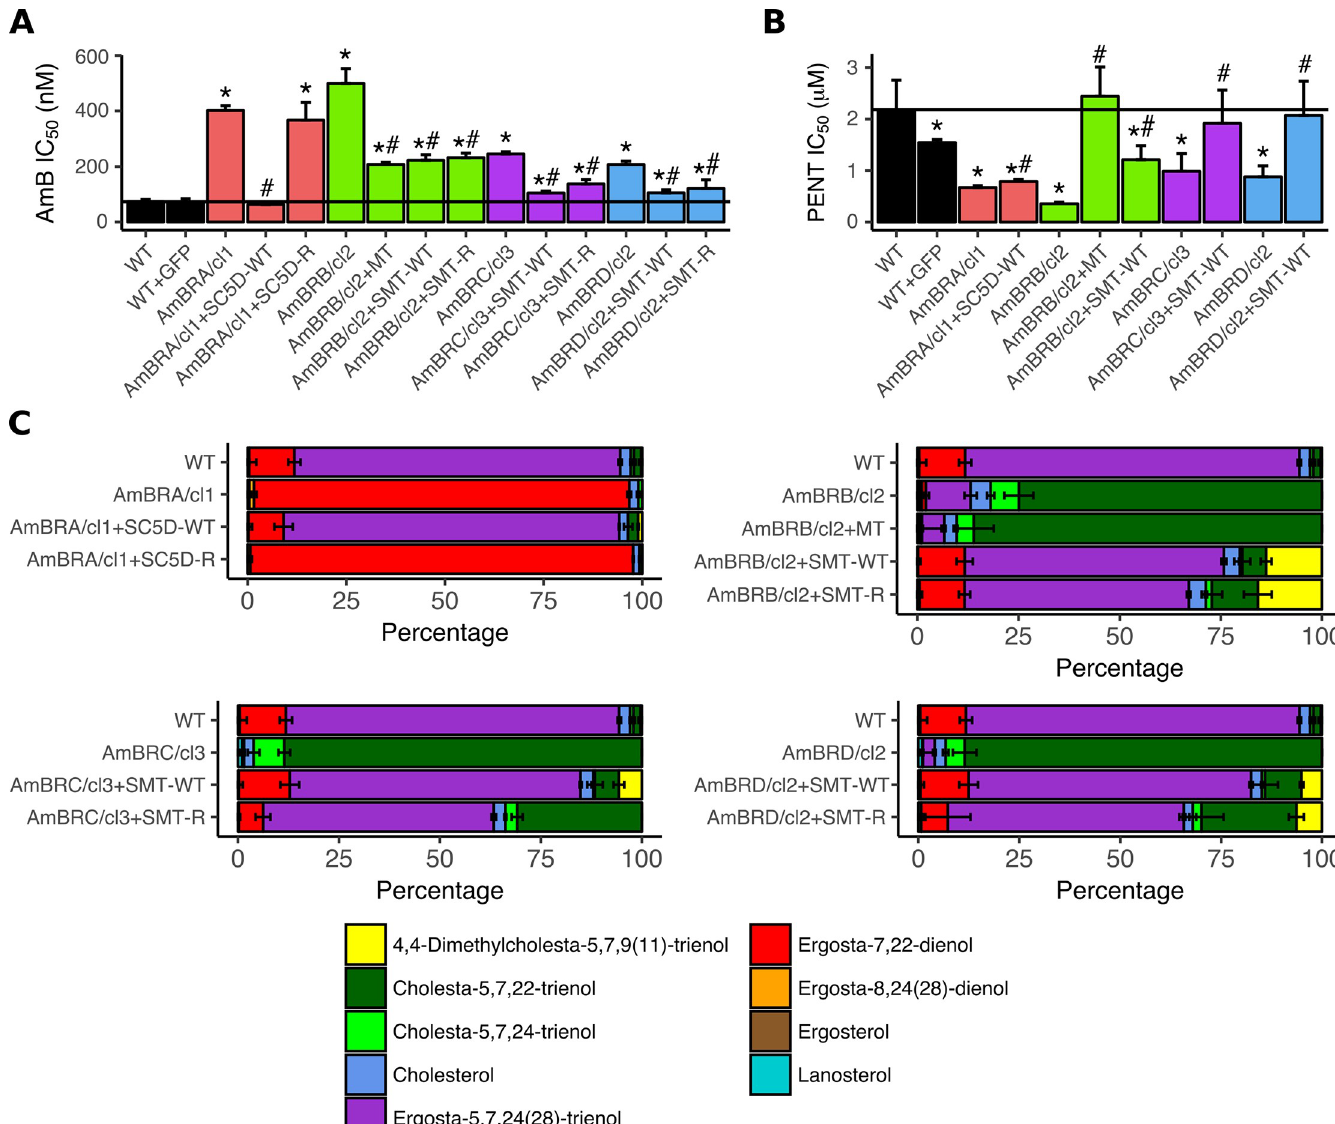
Fig 4. Effects of ectopic expression of candidate AmB resistance-associated genes. A) AmB sensitivity. Mean values are shown for IC 50 with error bars denoting standard deviation (n = 4, except for AmBRB/cl2 and AmBRD/cl2 (n = 6), and AmBRB/cl2 + MT, AmBRB/cl2 + SMT WT and AmBRD/cl2 + SMT WT (n = 8)). Asterisks represent significant differences (P < 0.05), compared to wild-type, hashes between ectopic overexpression lines and their parental AmB-resistant lines. The black vertical bar denotes wild-type sensitivity. See S5 Table for full data, including individual P values. B) Pentamidine (PENT) sensitivity. As for panel (A), with n = 5 for all lines. C) Percentage sterol composition, as determined by GC-MS. Error bars represent standard deviation of the mean, n = 3. MT: Miltefosine